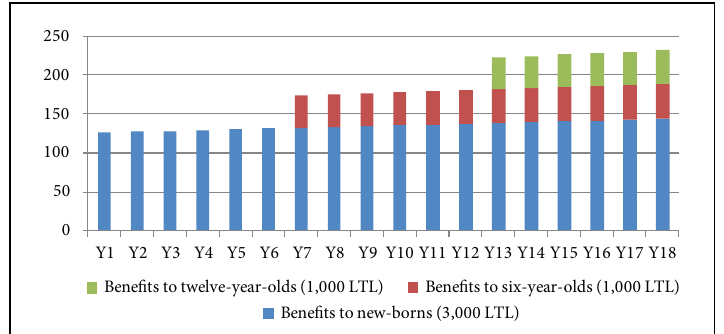
Fig. 14. Financing needs of the asset-based policy, in million LTL (authorial computation)